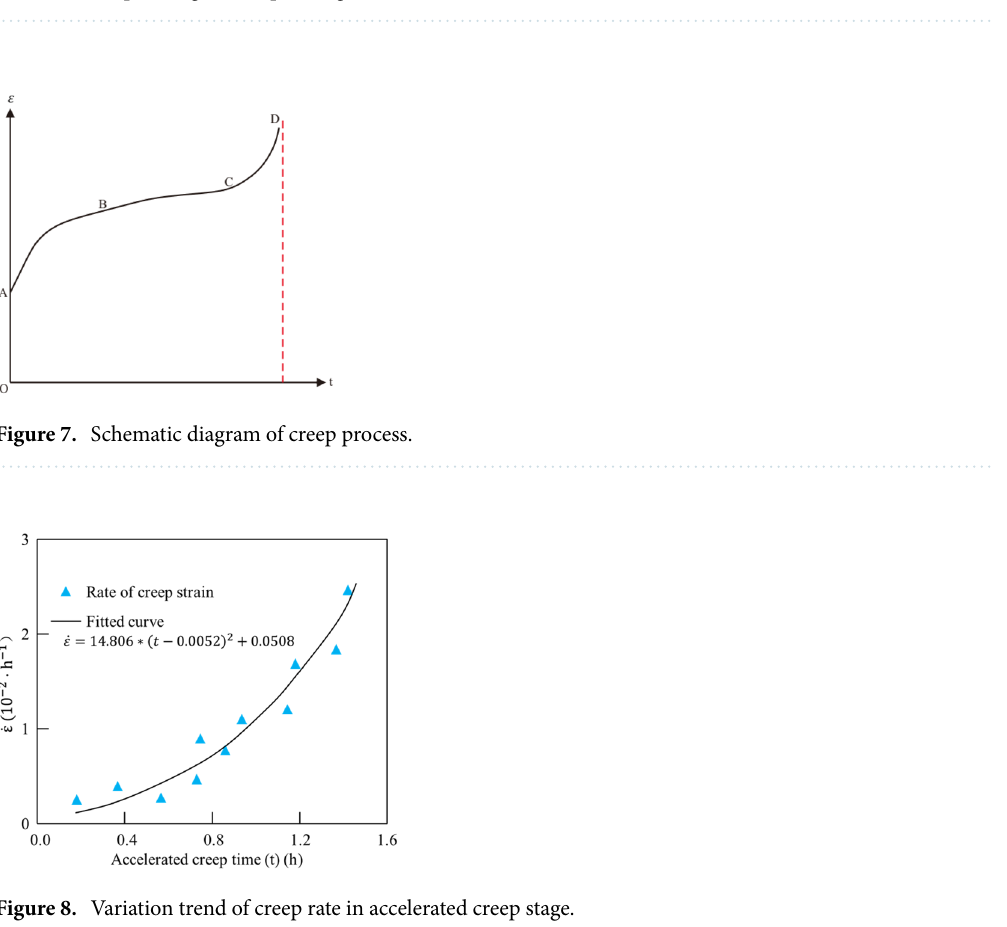
Table 2. Creep damage corresponding to different moisture content.